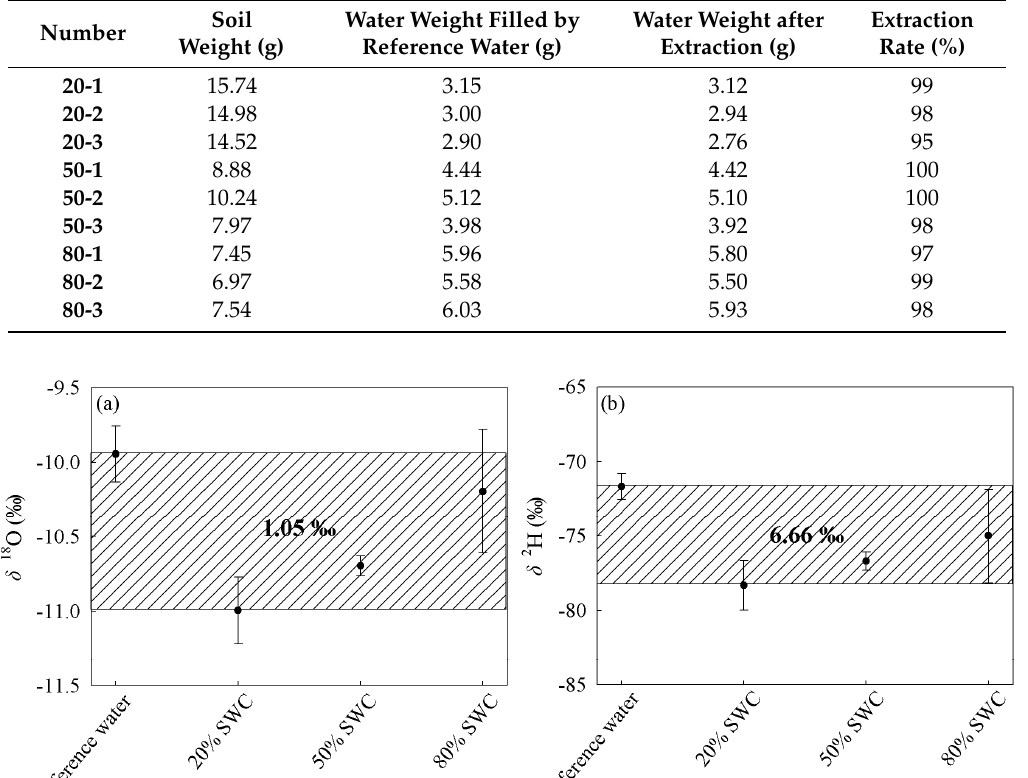
Table 10. Information about the extraction efficiency of LI-2100.